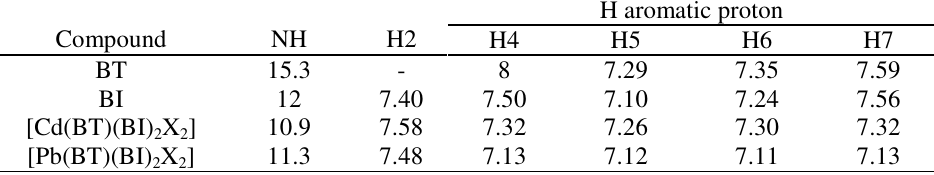
Table 4. 1 H NMR chemical shifts ( δ , ppm) of the free ligands and its complexes